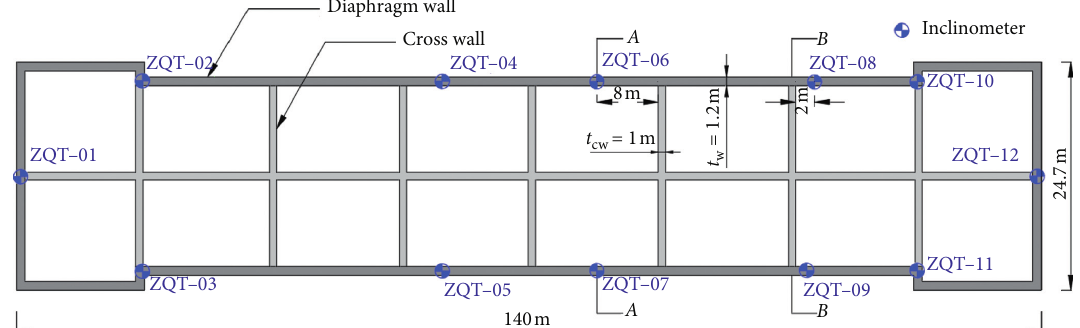
Figure 2: Geometric plane of retaining wall and monitoring layout.